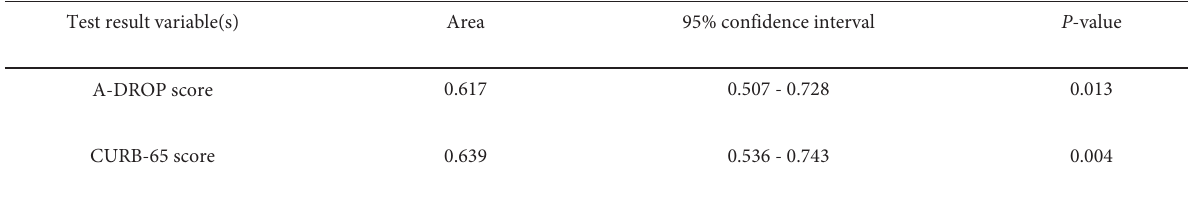
Figure 3: Receiver operating characteristic (ROC) curves for (—) A-DROP score and (- - -) CURB-65 score to predict hospital revisit rate within 72 hours after discharge from the emergency department in patients with community-acquired pneumonia. (....) Reference